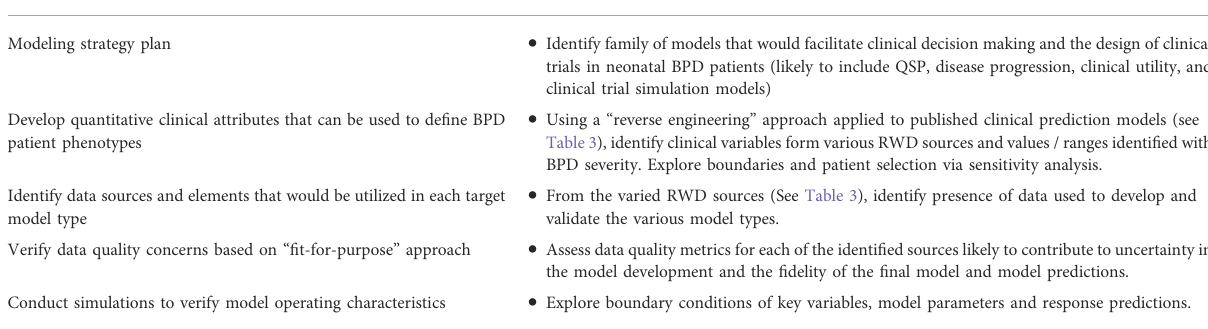
TABLE 2 Proposed workplan — critical requirements of the BPD disease progression model effort based on initial scoping from INC working group. Task